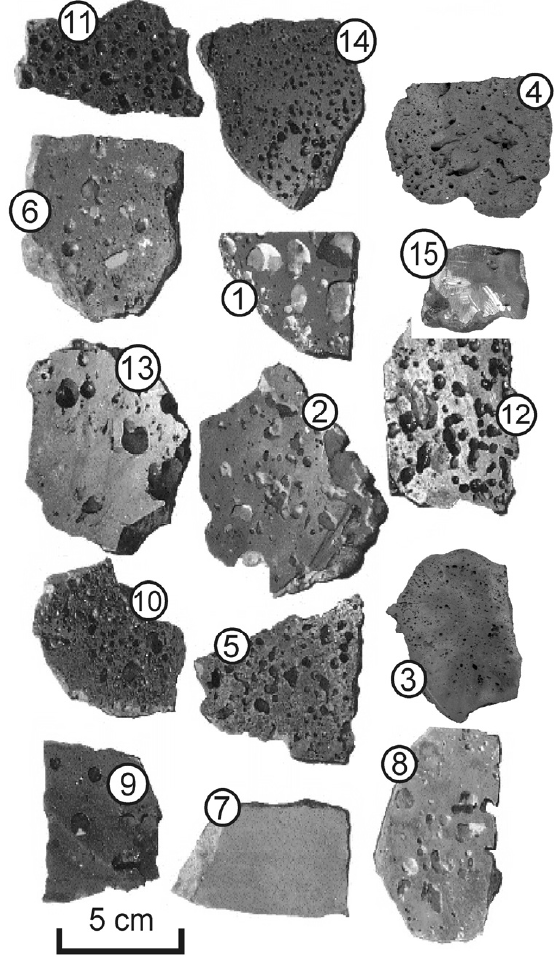
Fig. 2 – Fifteen of the more representative steel slags samples, se- lected among 200 specimens, from different places of Villaverde- Getafe-Parla in an area of 10 km 2 in the southern part of Madrid.